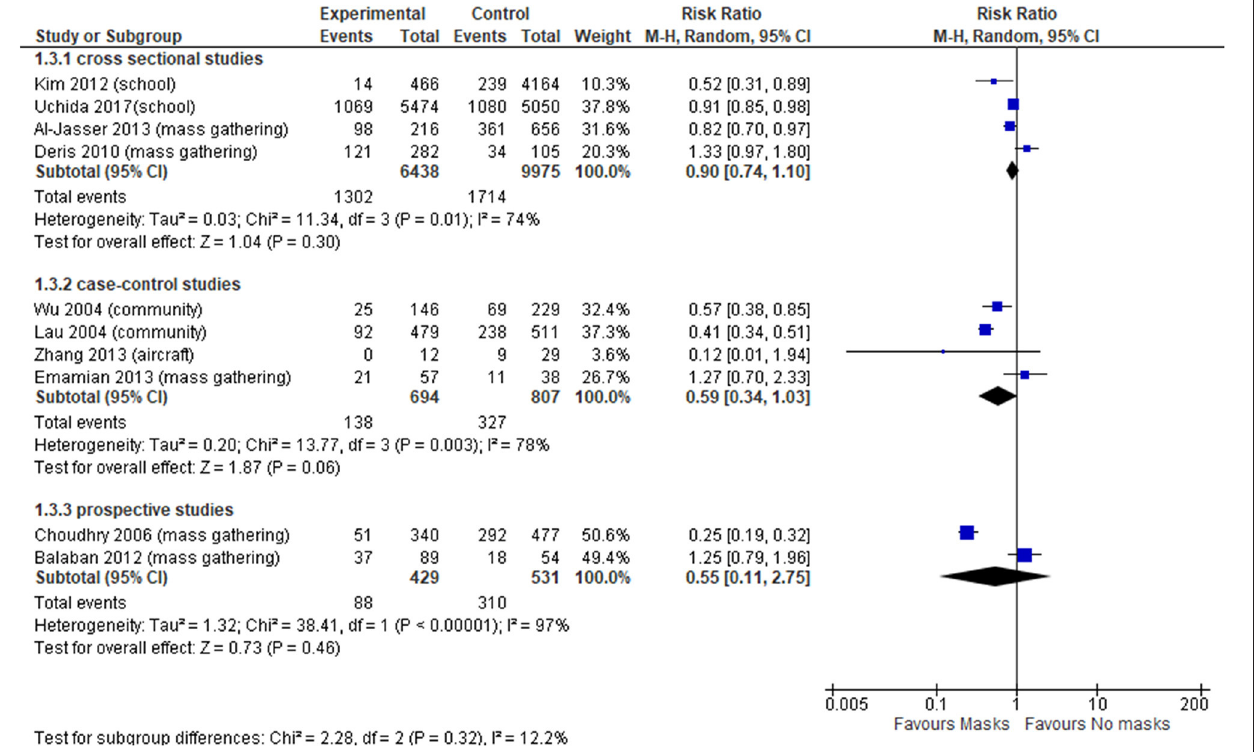
FIGURE 3 | Forest plot of respiratory infection rate in observational